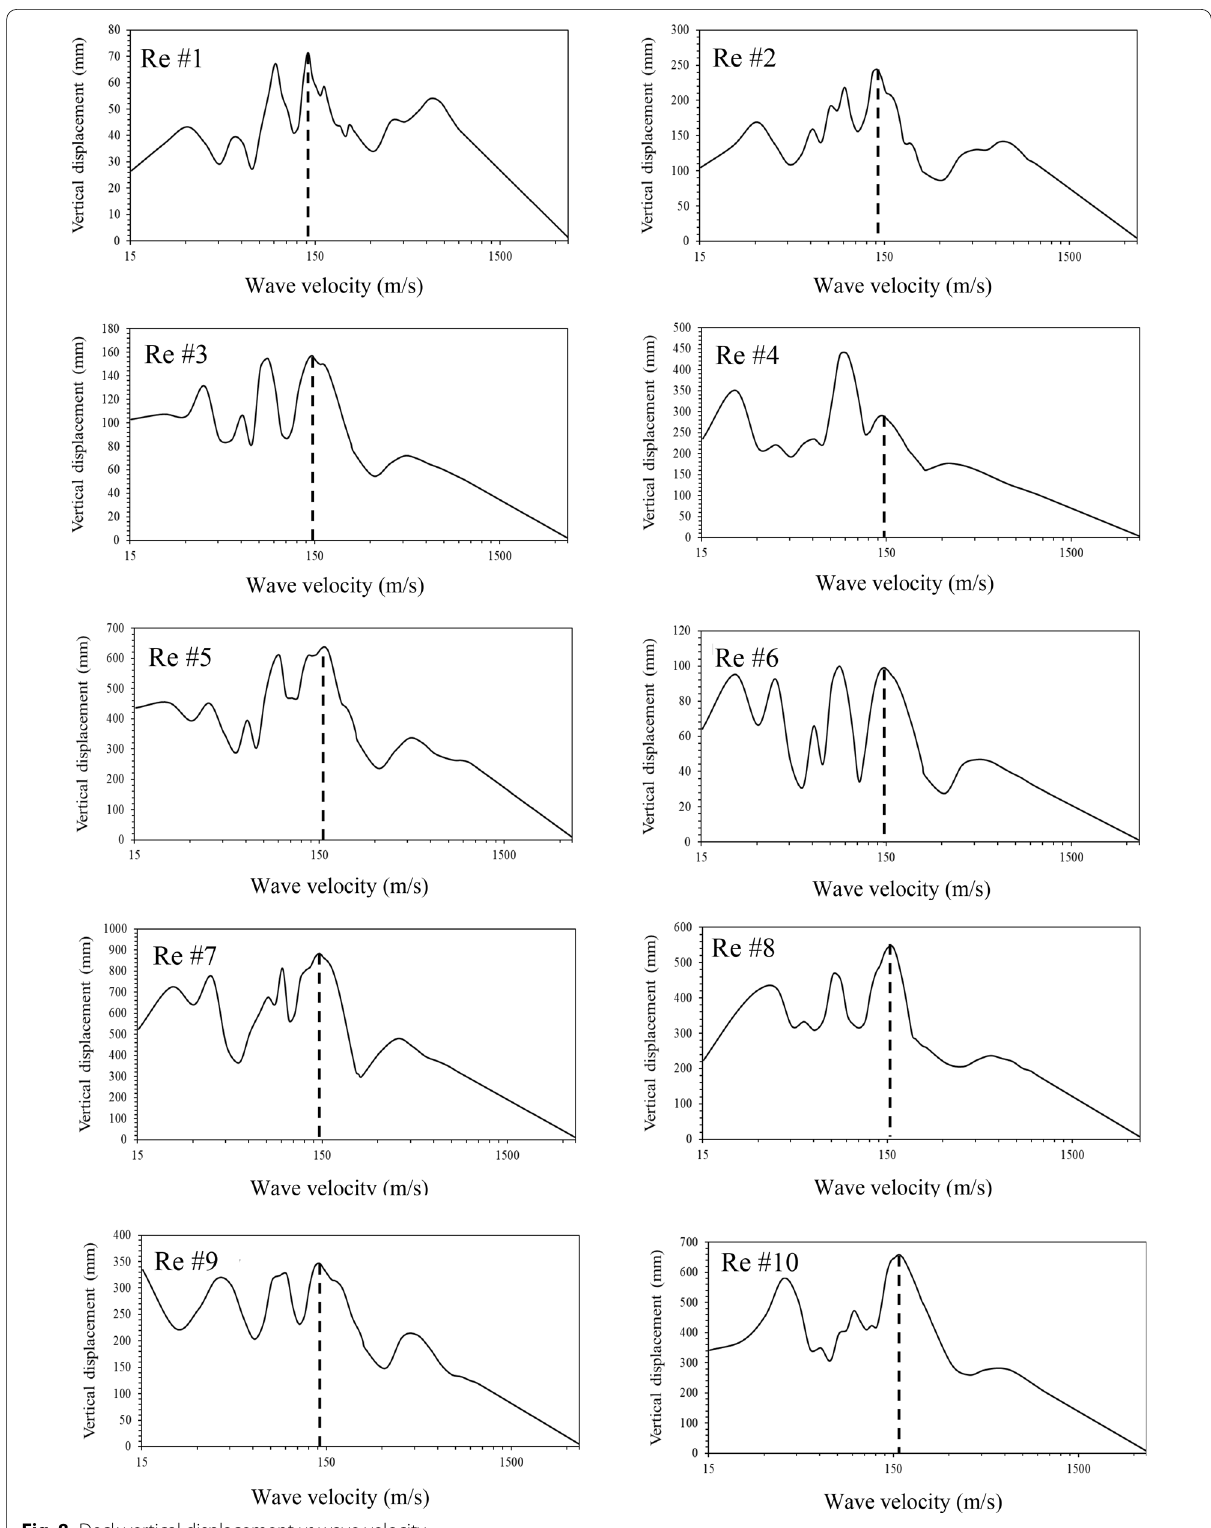
Fig. 8 Deck vertical displacement vs wave